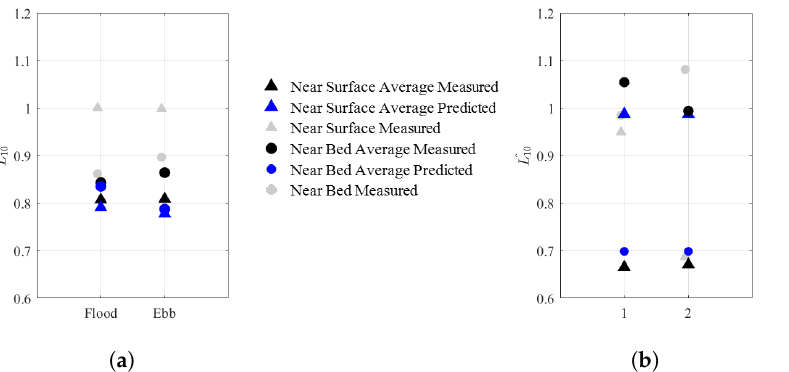
Figure 9. Normalised damage equivalent loads for each turbine position and location, calculated using the measured shear profiles and varying fluctuation intensity, with all samples and with wave cases removed. ( a ) Location A. ( b ) Location